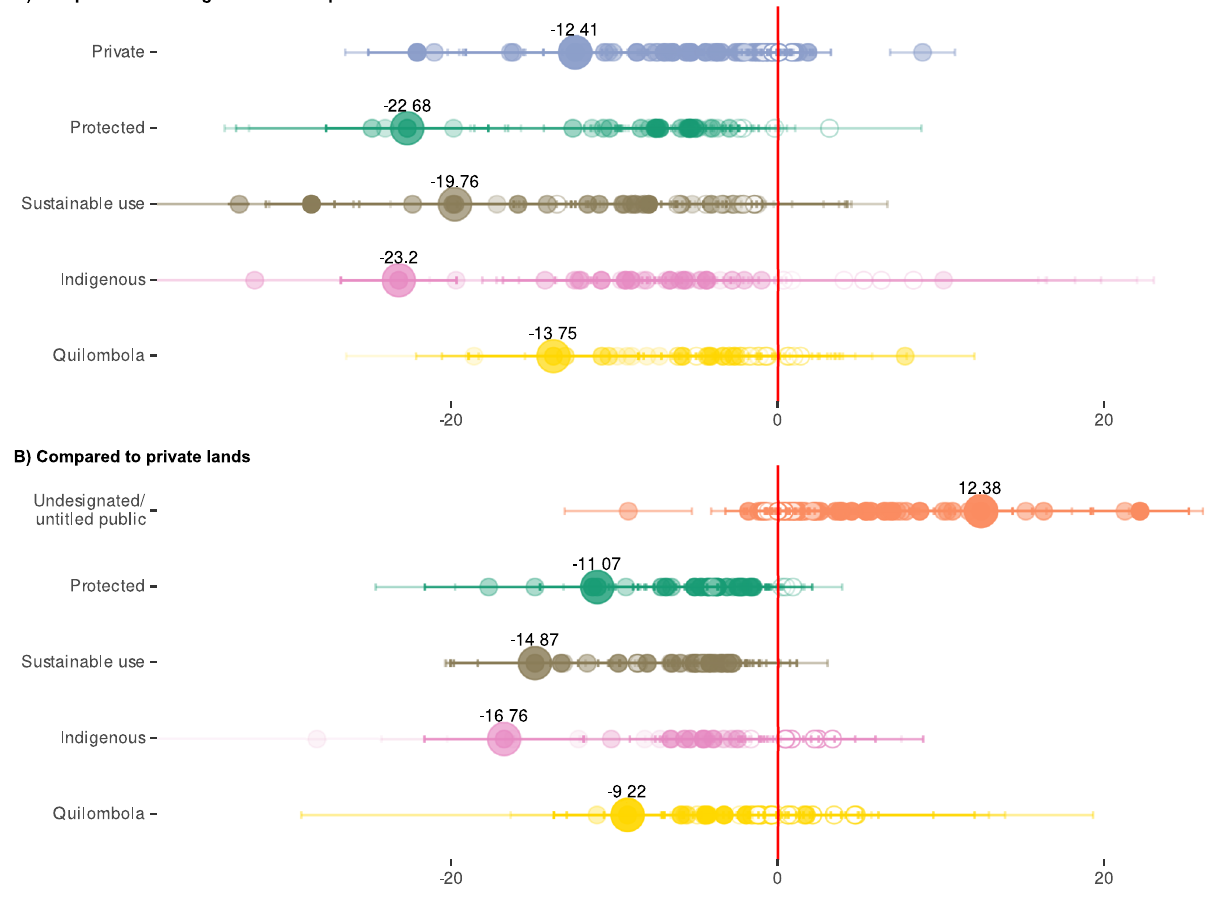
Fig. 2 | Effects of alternative land-tenure regimes on forest-to-agriculture conversion rates in Brazil. Circles indicate average effects sizes estimated using regression analysis (using matched parcels) at different spatial-temporal scales, comparedtotwoalternativecounterfactuals: A undesignated/untitledpubliclands with poorly de fi ned tenure rights, and B private lands. Labelled effect sizes (larger circles) report effects across Brazil over the time period 1985 – 2018. Effects to the leftofthezerolineindicateadecreaseinaverageparcel-leveldeforestationrate(to